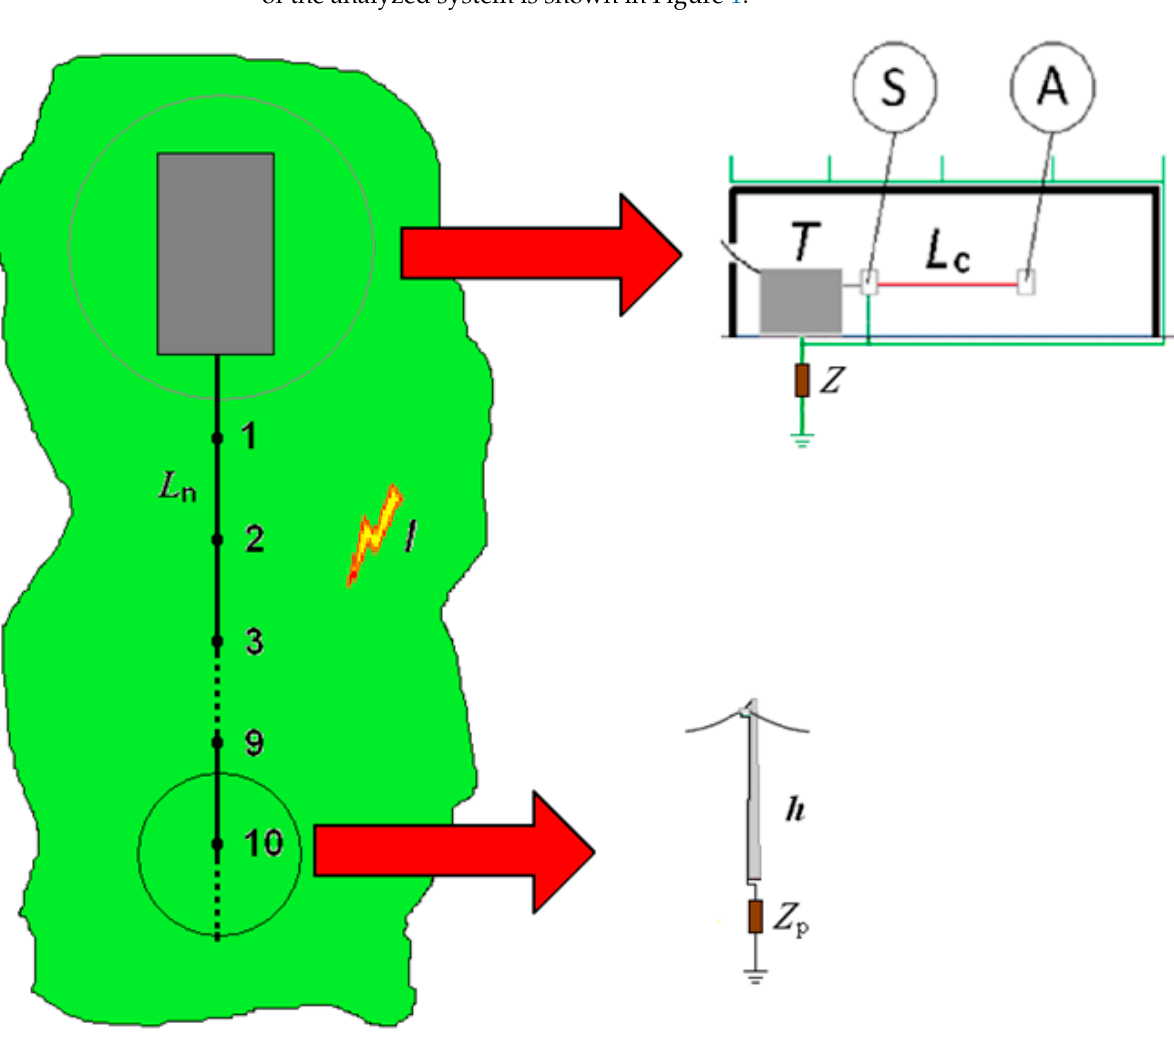
Figure 1. Schematic representation of case study under consideration, where: A —apparatus to be protected; L C —length of circuit between transformer and apparatus; S —main LV panel board; T —Transformer HV/LV; Z —structure conventional earthing impedance; L n —overhead line span length; 1-2-3-…-9-10—number of poles; I —lightning flash to ground near a line; h —pole height; Z p —poles conventional earthing impedance.